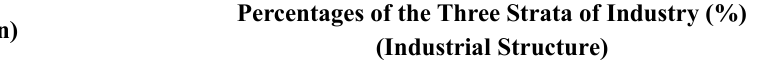
Table A3. GDP by sectors.